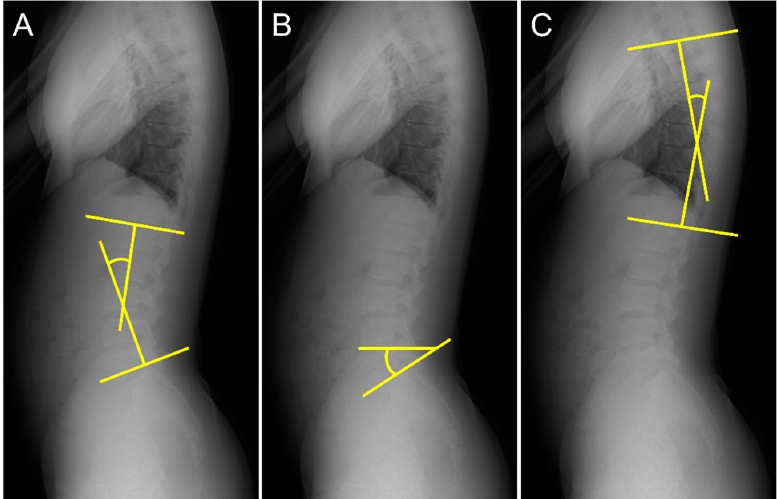
Figure 2. Measurement of spinal alignment. ( A ) Measurement of the lumbar lordosis angle (LL), ( B ) sacral slope angle (SS), and ( C ) thoracic kyphosis angle